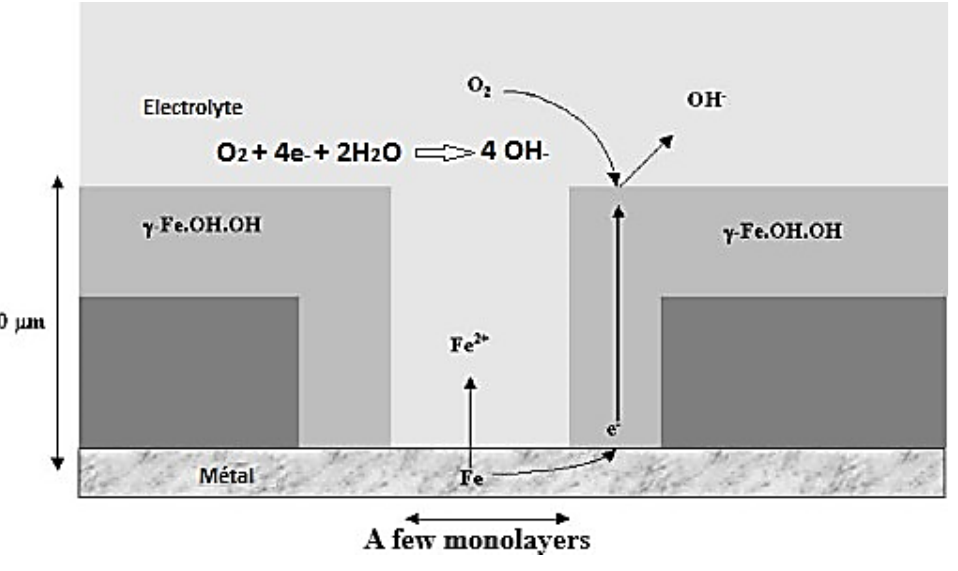
Figure 6. Representation of the phenomena occurring during the wet phase.